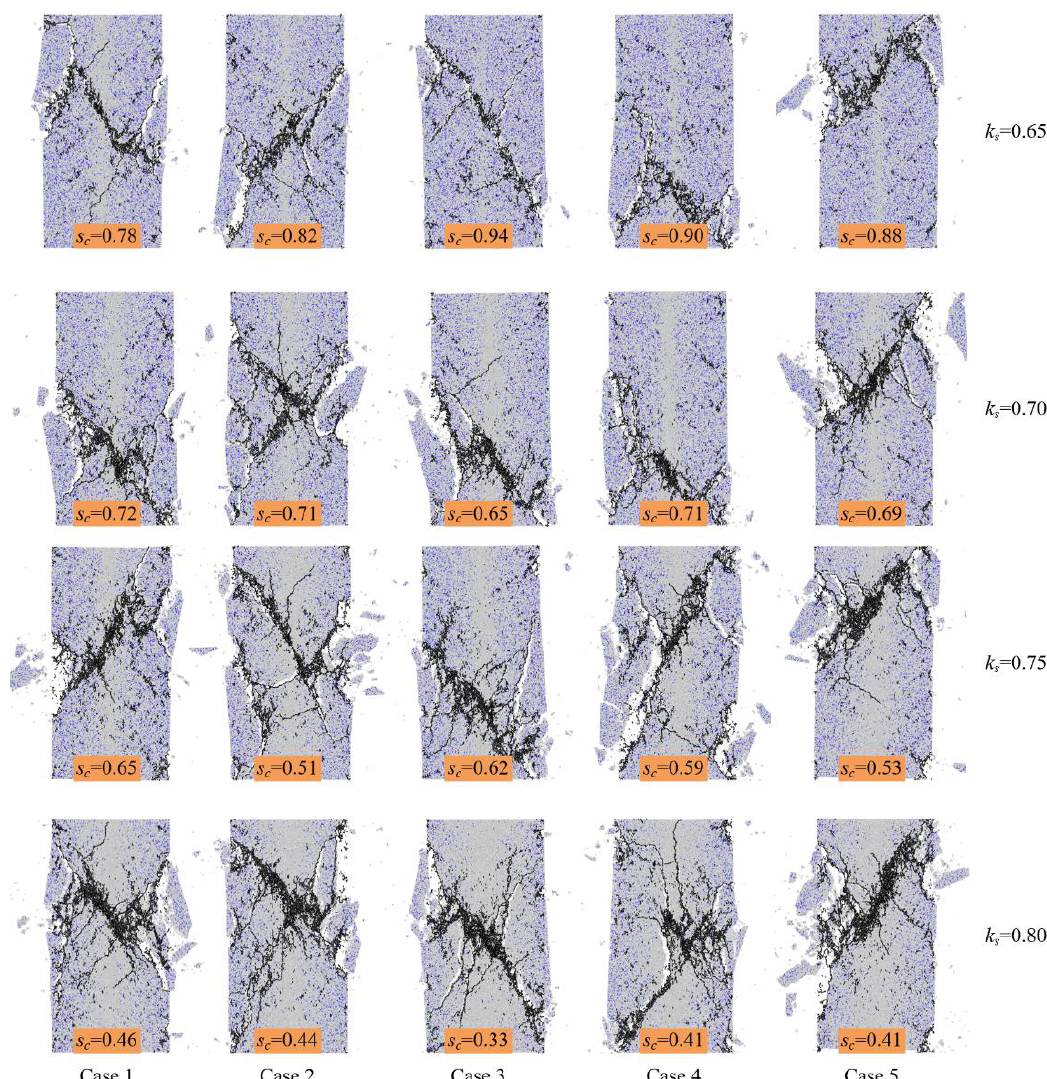
Figure 12. Final failure patterns of all damaged specimens.